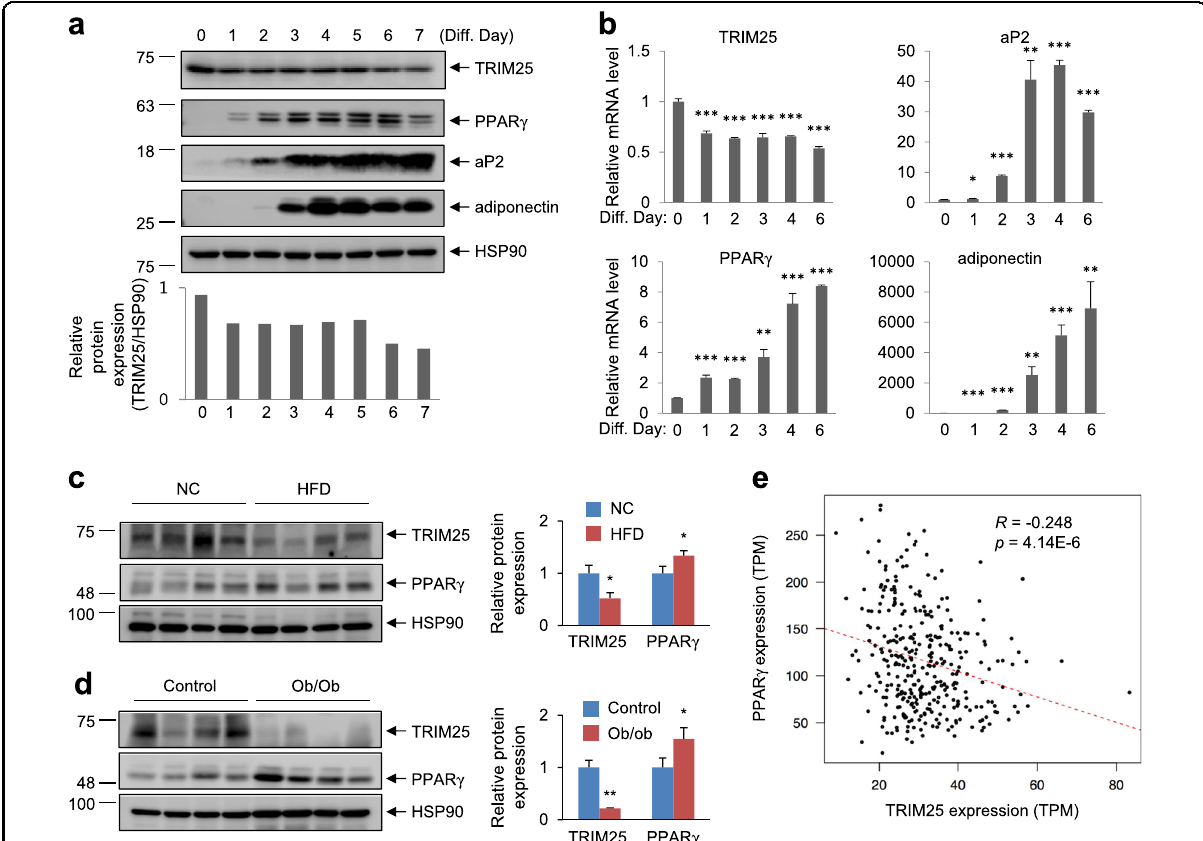
Fig. 5 Negative correlation between TRIM25 and PPAR γ expression both in mice and humans. a Immunoblot analysis of TRIM25, PPAR γ , and adipogenic markers during 3T3-L1 cell differentiation. Relative TRIM25 protein levels were measured using ImageJ (bottom graphs). b Real-time quantitative PCR analysis of the mRNA expression of TRIM25, PPAR γ , and adipogenic markers during 3T3-L1 cell differentiation. c Immunoblot analysis of TRIM25 and PPAR γ in white adipose tissue (WAT) of normal chow-fed (NC) vs. high-fat-fed (HFD) mice. d Immunoblot analysis of TRIM25 and PPAR γ in WAT of control vs. ob/ob mice. Relative TRIM25 and PPAR γ protein levels were measured using ImageJ (right graphs). e Pearson correlation coef fi cients between TRIM25 and PPAR γ levels within human subcutaneous fat samples were calculated. All error bars shown are the s.e.m. (* p < 0.05, ** p < 0.01, *** p <